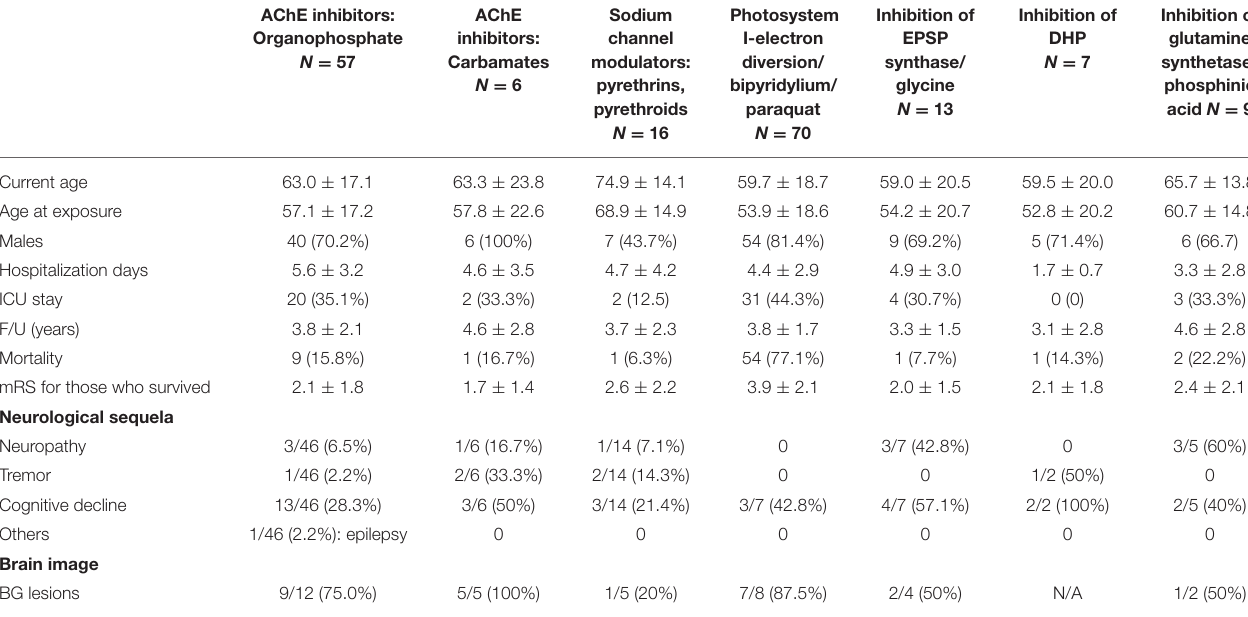
TABLE 1 | Clinical characteristics, prognosis and neurological sequela of patients in this study. AChE inhibitors: Organophosphate